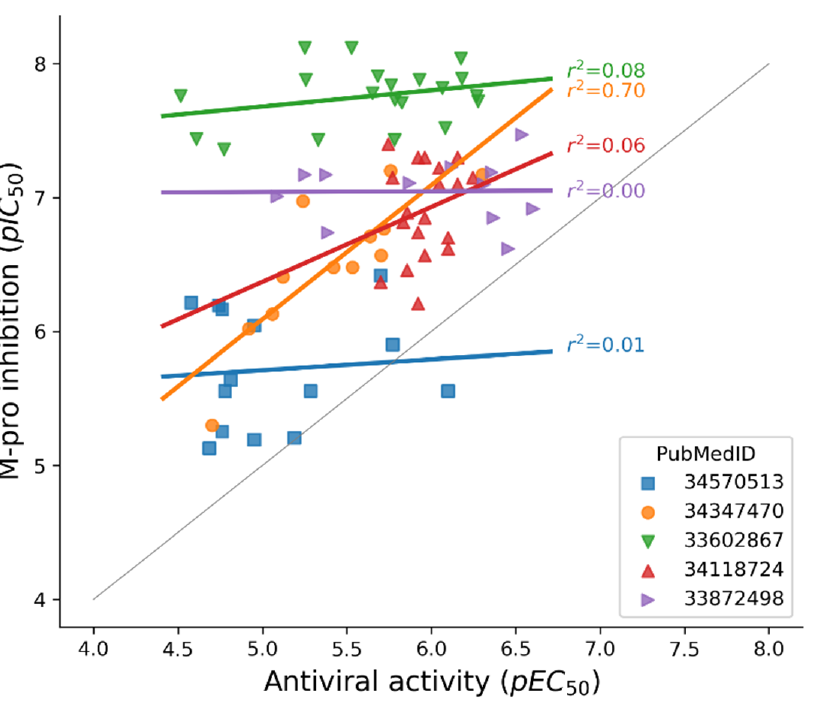
Figure 6. Comparison between the pIC 50 values of some SARS-CoV-2 M-pro inhibitors and their antiviral activities, measured as pEC 50 values. To avoid comparisons between values from different laboratories, data from five articles that calculate the pIC 50 and pEC 50 for a set of compounds are shown independently. The PubMedID of the articles is indicated. A gray line represents the diagonal where pIC 50 and pEC 50 values are